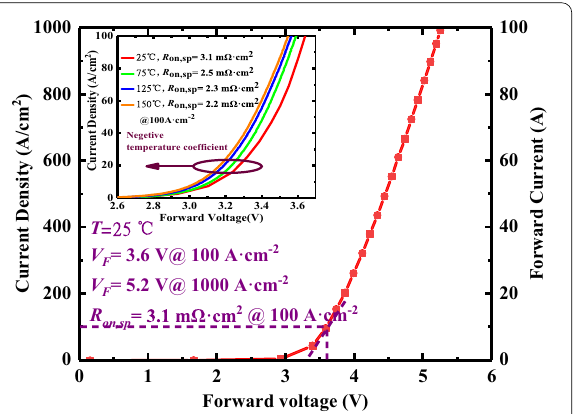
Fig. 11 Forward I–V curve of the CFM‑JTE PiN rectifier and characteristics at diverse temperature environments in the